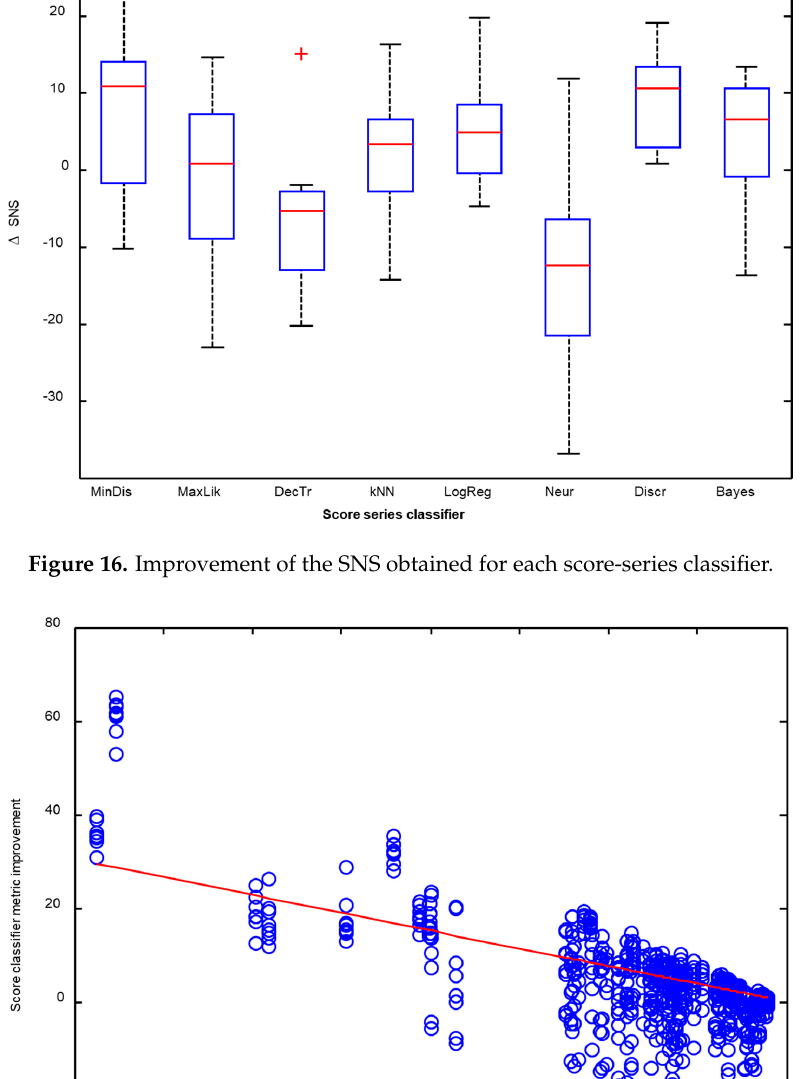
Figure 15. Matrix of SNS values for every pair (score, frame) classifiers.